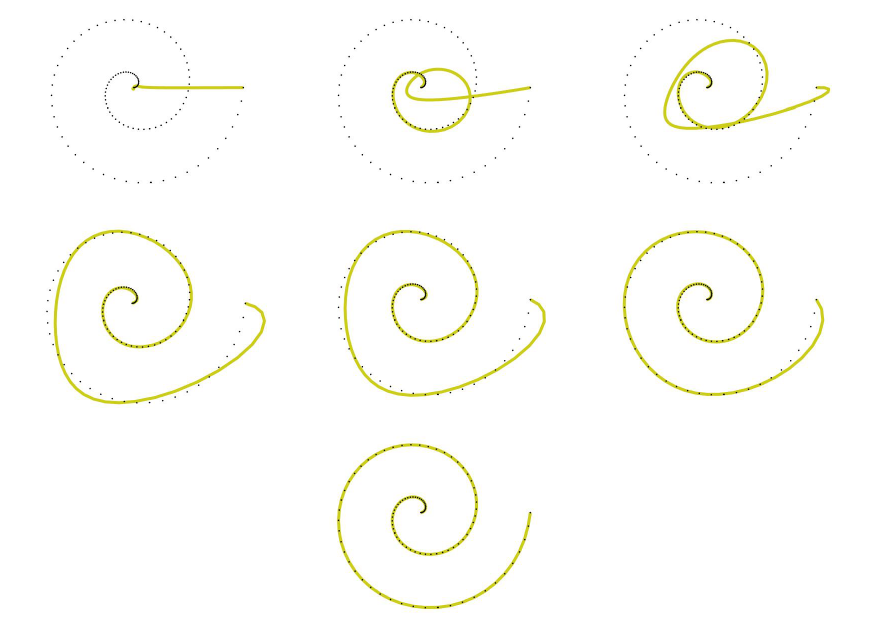
Figure 4. Evolution of the fitting curve N w , P ( t ) . Set of data points from the target curve (dotted) and the fitting curve (line). From top to bottom and left to right: Increment d = 0, d = 250, d = 500, d = 1000, d = 1500, d = 2000 and d =